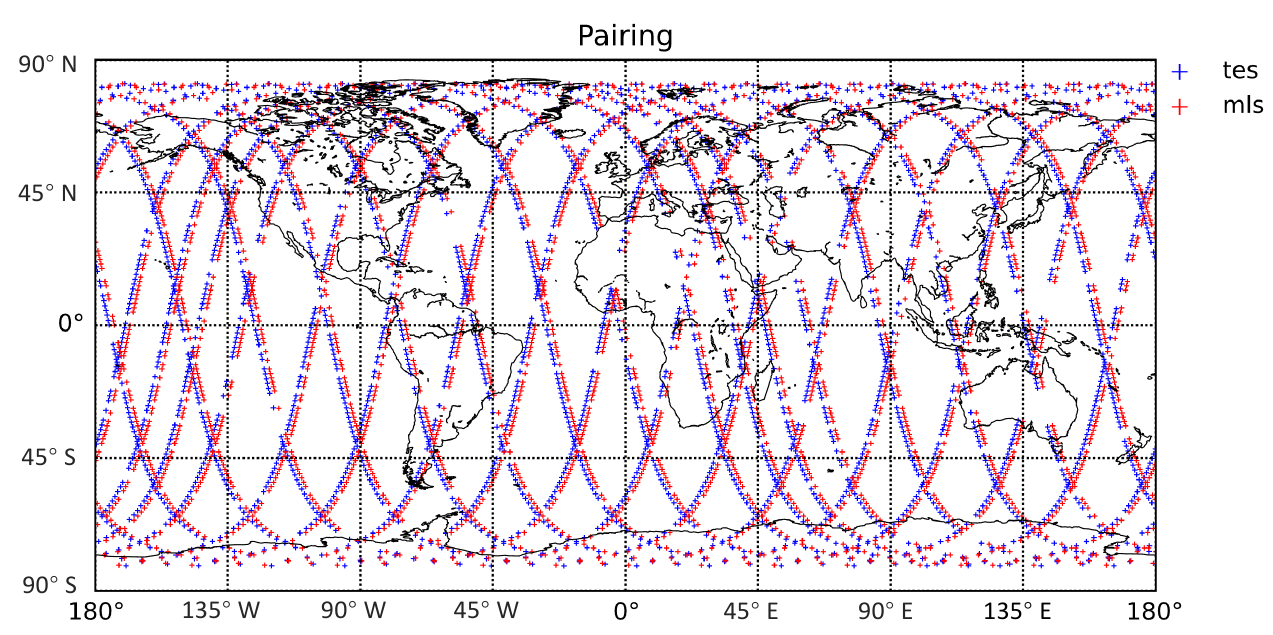
Figure 2. The pairing result of TES locations (blue) and MLS locations (red) on 8–9 July